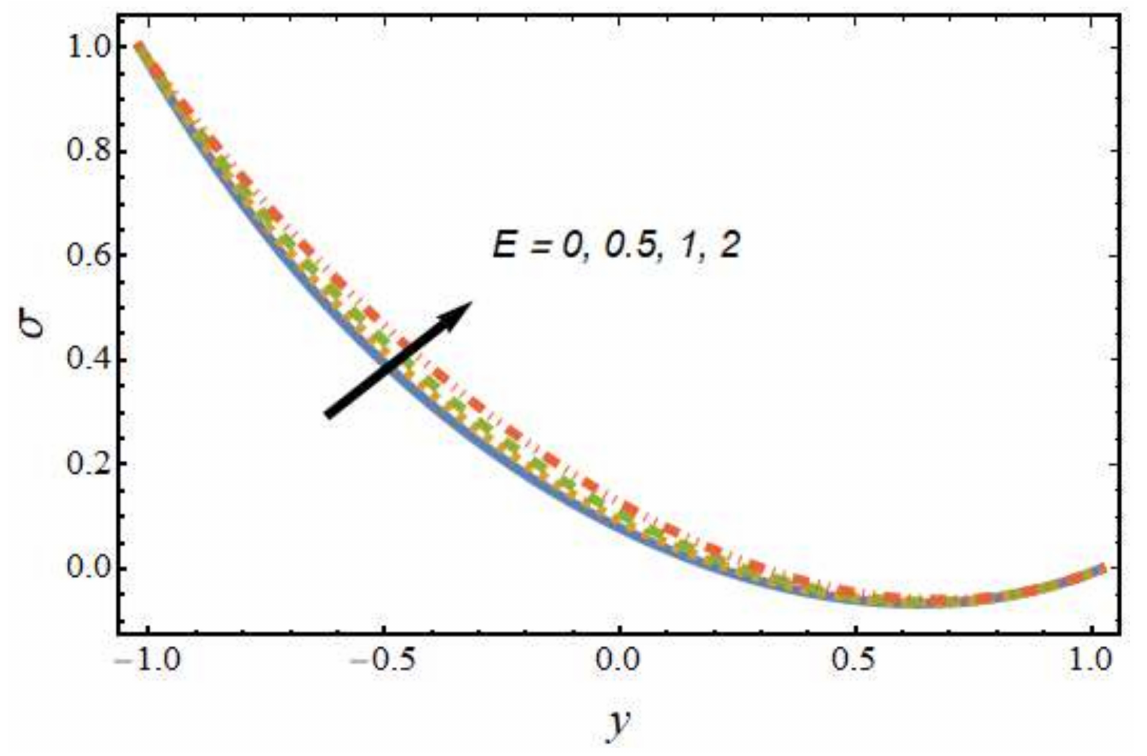
Figure 14. Nanoparticle concentration profile for various values of the activation energy parameter.